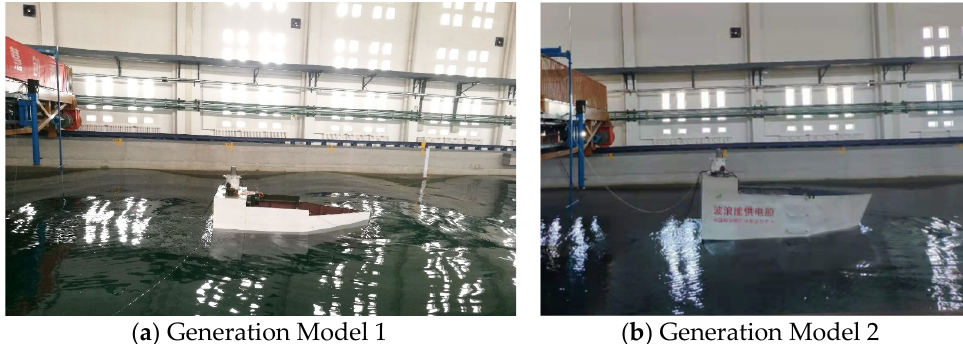
Figure 9. The test site of the BBDB wave energy conversion laboratory physical model.